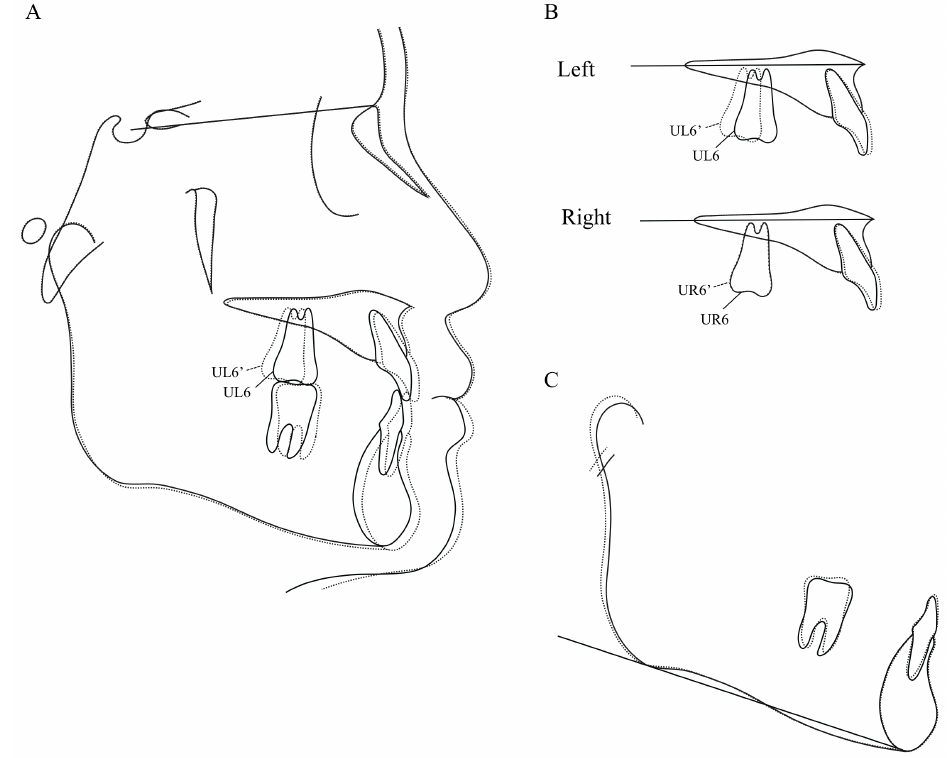
Figure 10. Superimposition at the start of active treatment and at removal of the Hyrax-type expander. At the start of active treatment (14 years 4 months) (solid line); at removal of the Hyrax-type expander (15 years 8 months) (dashed line). ( A ) On the SN plane at S. ( B ) On the palatal plane at ANS. ( C ) On the mandibular plane at Me. Maxillary left first molar at the start of active treatment (UL6); left first molar at removal of the Hyrax-type expander (UL6 (cid:48) ); maxillary right first molar at the start of active treatment (UR6); maxillary right first molar of the Hyrax-type expander (UR6 (cid:48) ). When active treatment was terminated, SNA was increased by 0.5 ◦ compared with